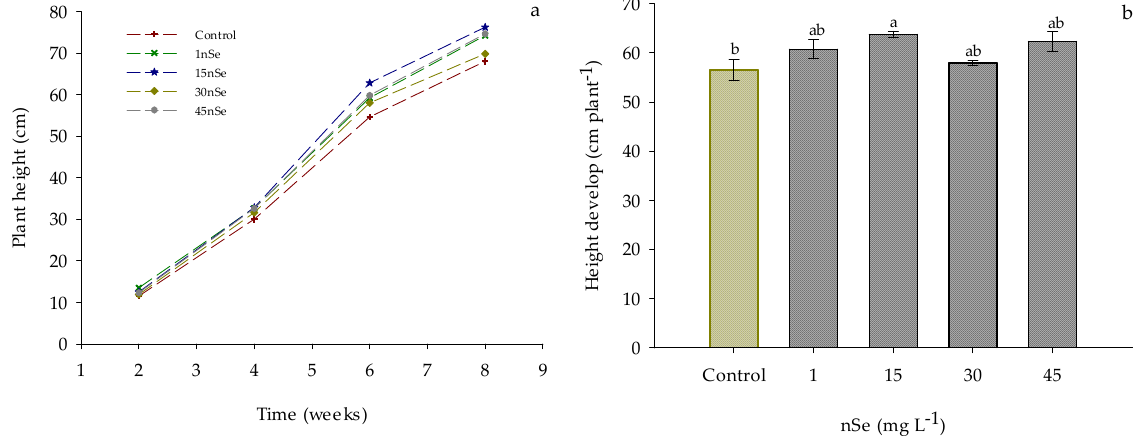
Figure 1. Growth dynamics of Jalapeño pepper plants with nSe application. ( a ) weekly growth; ( b ) total height gain. Different letters indicate a difference between treatments (Tukey test p ≤ 0.05). n = 5 ± standard error.